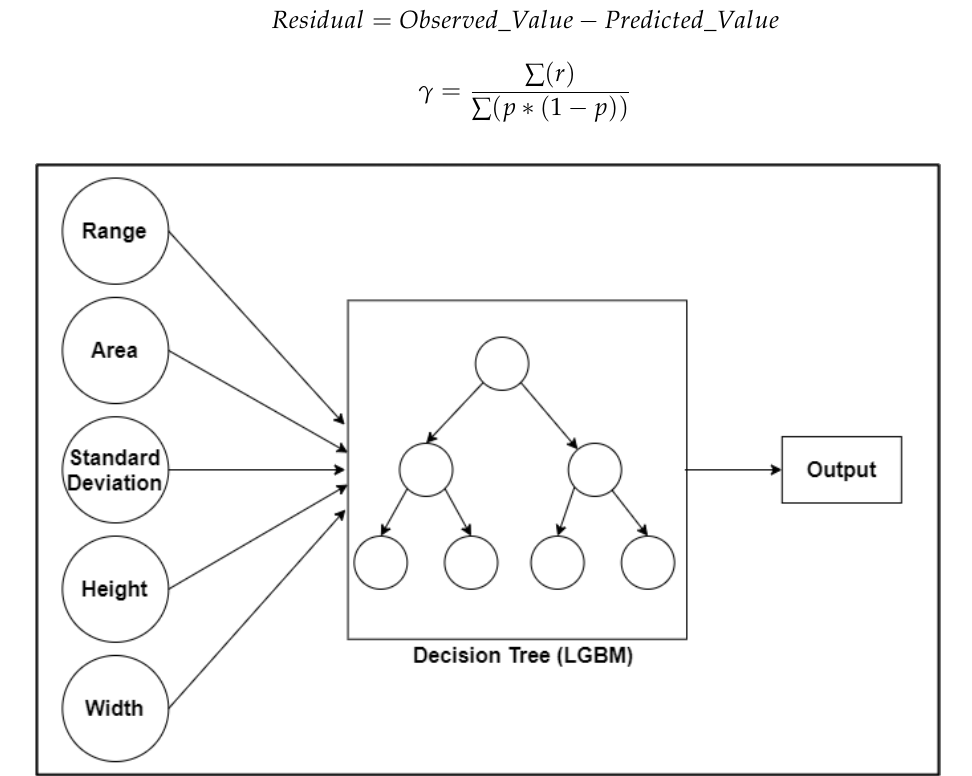
Figure 16. Light Gradient Boost Methods